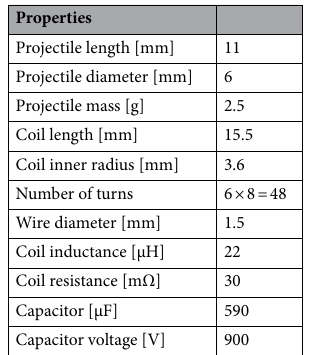
Table 1. The coil and projectile